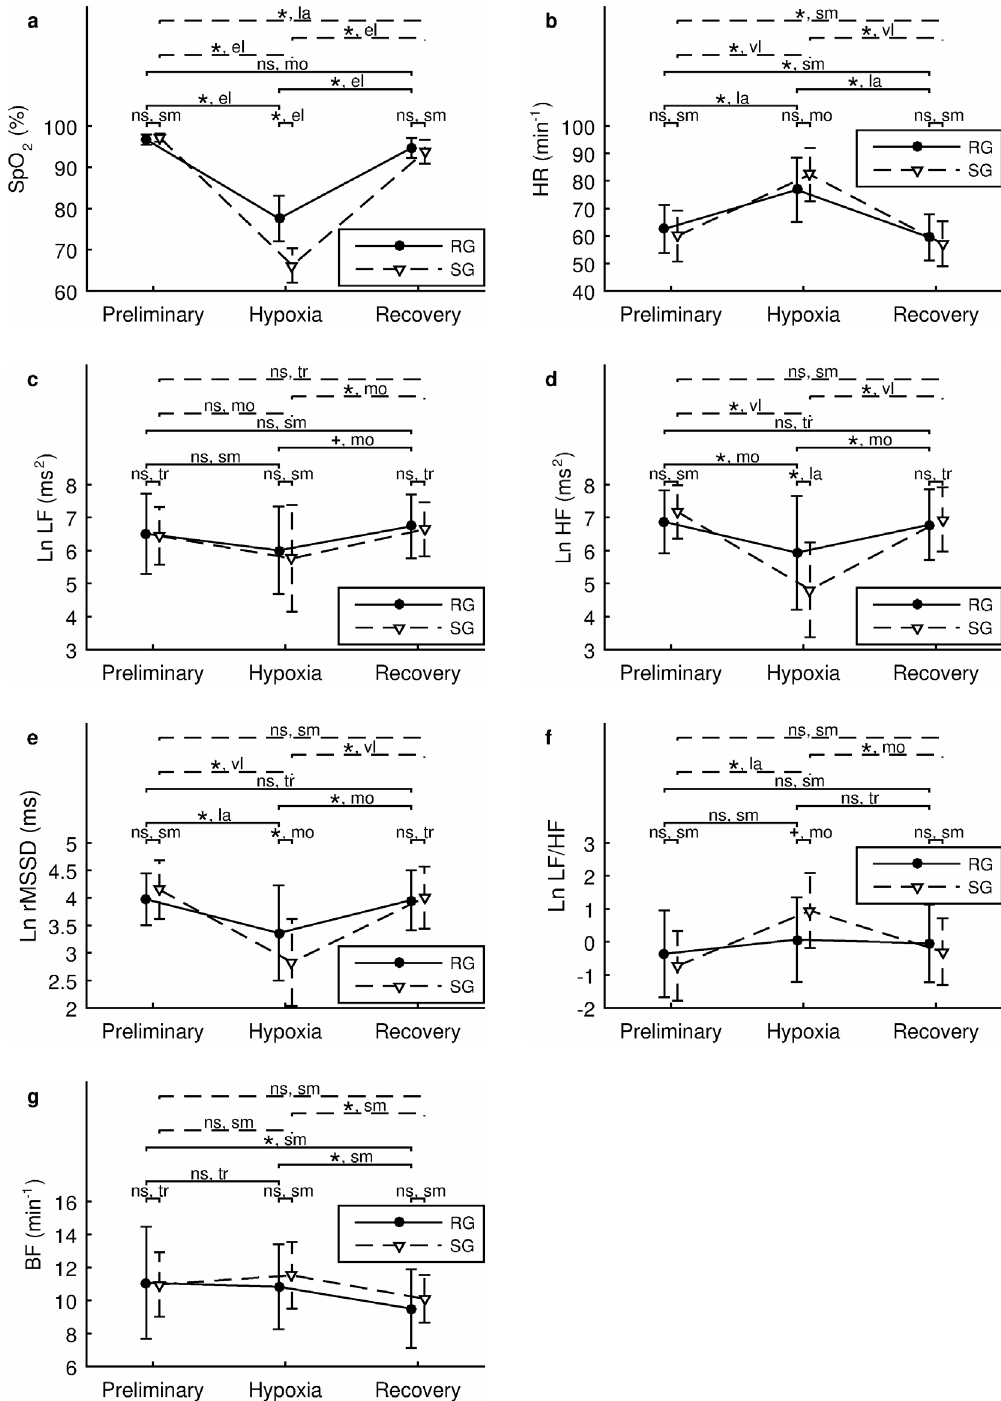
Figure 2. Changes in the oxygen saturation (a), heart rate (b), natural logarithm of low fre- quency power (c), natural logarithm of high-frequency power (d), natural logarithm of square root of the mean of the squares of the successive differences (e), natural logarithm of low-fre- quency/high-frequency ratio (f) and breath frequency (g) during Preliminary, Hypoxia, and Re- covery phases. Values are presented as the mean ± standard deviation. Comparisons by means of Fisher’s LSD post-hoc test are presented. RG = resistant group (saturation during hypoxia ≥ 70.9%, n = 14); SG = sensitive group (saturation during hypoxia < 70.9%, n = 14); * = p < .05; + = .05 ≤ p < .06; ns = nonsignificant; tr = trivial effect size (| d | < 0.2); sm = small effect size (| d | ≥ 0.2); mo = moderate effect size (| d | ≥ 0.6); la = large effect size (| d | ≥ 1.2); vl = very large effect size (| d | ≥ 2.0); el = extremely large effect size (| d | ≥